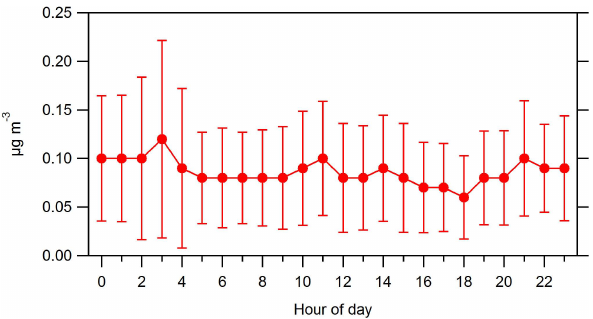
Fig. 8. Average levoglucosan concentration for each hour of day during the campaign. The vertical lines represent one standard de-